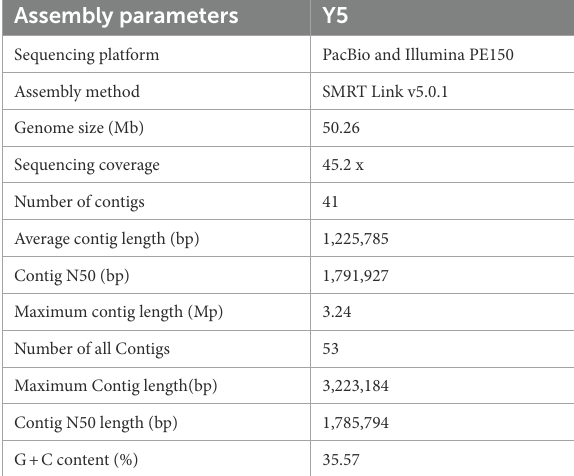
TABLE 5 Genome characteristics and predicted features of the assembled Rhizopus oryzae strain Y5. Assembly